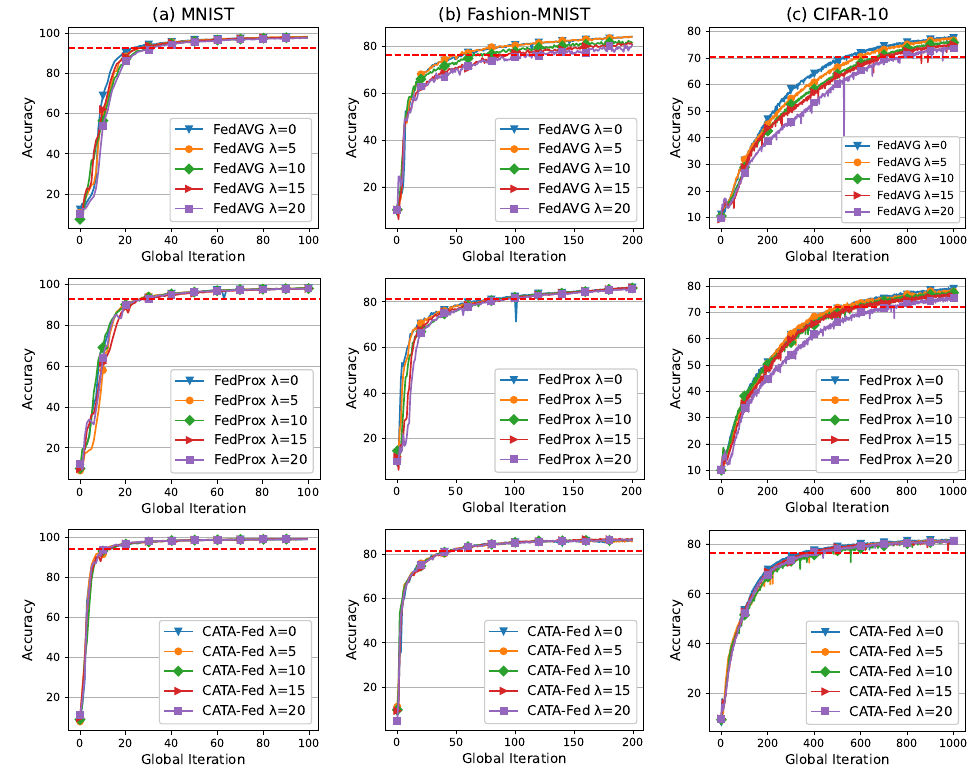
Figure 11. Test set accuracy of FedAVG ( top ), FedProx ( middle ) and CATA-Fed ( bottom ) vs. global iterations for ( a ) MNIST, ( b ) Fashion-MNIST, and ( c ) CIFAR-10 under IID setting with tentative straggler ratio λ = [ 0,5,10,15,20 ] , deadline T =